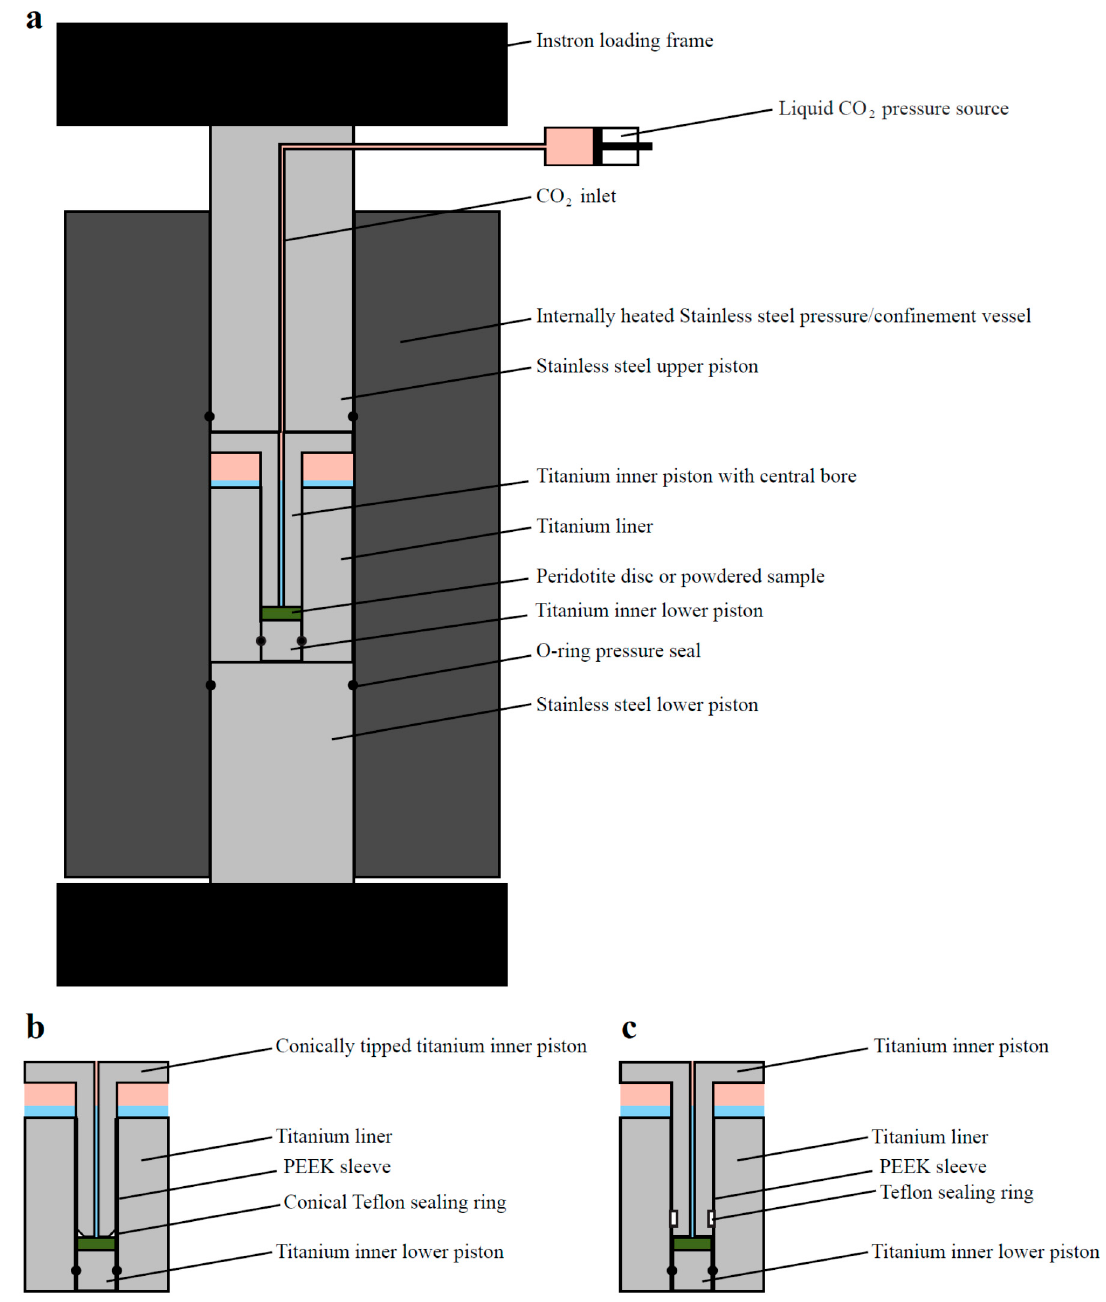
Figure 2. A simple schematic representation of the setup used in the force of crystallization experiments. ( a ) The entire apparatus in general, with the titanium liner as used in the initial experiments. ( b ) The titanium liner, piston and sample assembly as used in experiments R0805–R0808. ( c ) The titanium liner, piston and sample assembly as used in experiments R0809–R0815. In experiment R0816 a different lower piston, with a fluid inlet, was used. Note that the apparatus is not drawn precisely to scale. The width of the inner piston is 10 mm. The outer width of the titanium liner